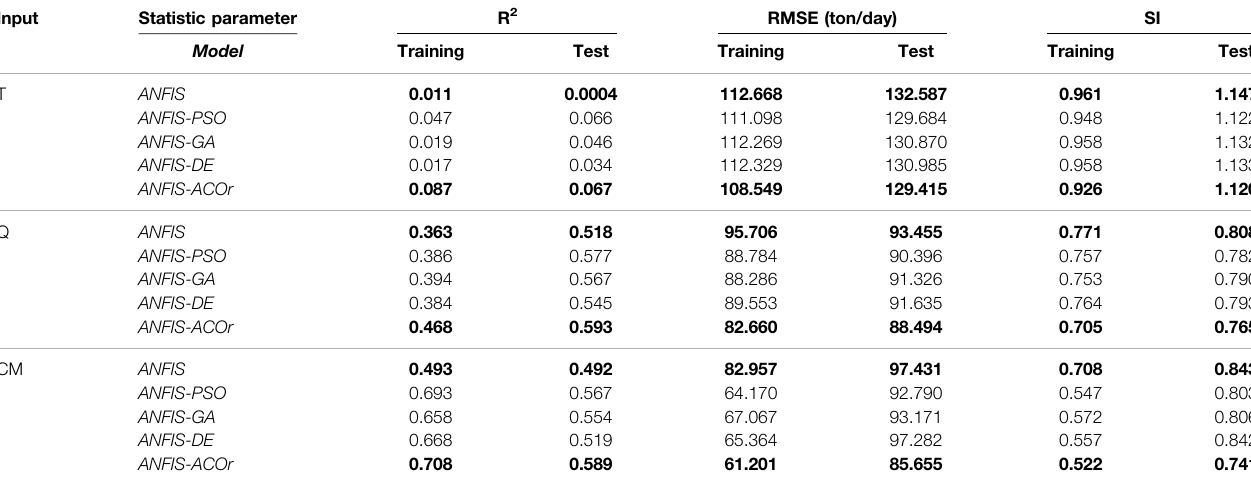
bold values are the highest achieved values for each algorithms.